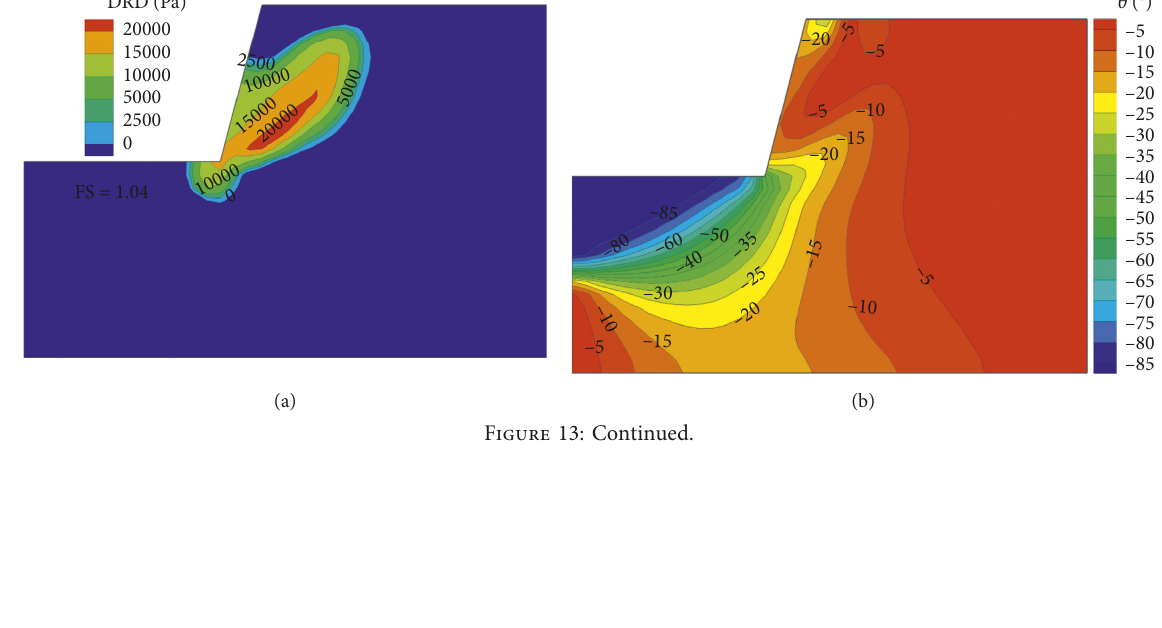
Figure 12: Design and comparison of reinforcement scheme at 90 ° slope. (a) The contour map of DRD for 90 ° slopes, (b) the azimuth of Δ σ for 90 ° slopes, (c) reinforcement design of quantitative reinforcement analysis, and (d) reinforcement design of Bishop’s simplified